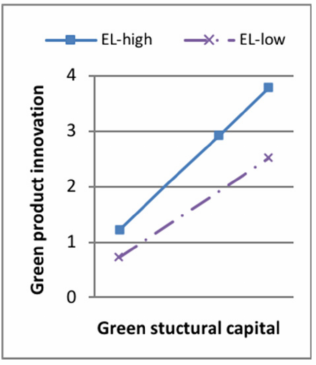
Figure 4. The moderating effect between GSC and GI1.